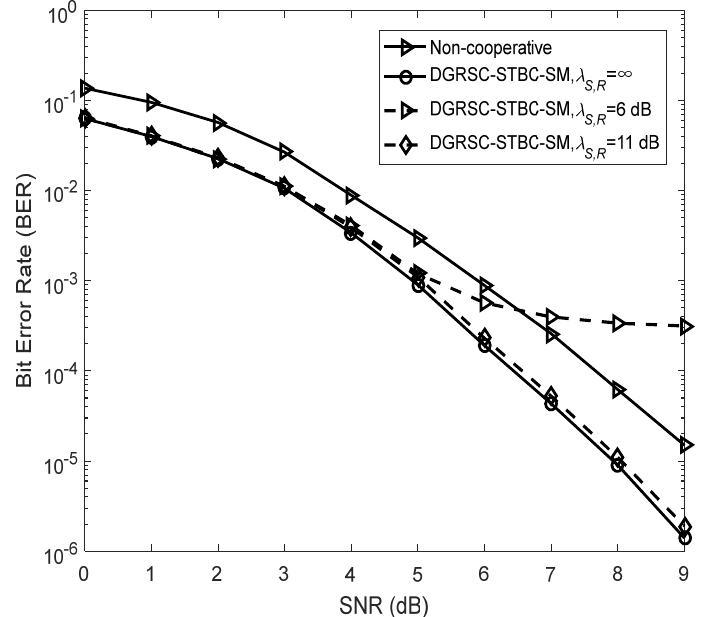
Figure 9. Comparisons between DGRSC − STBC − SM employing C